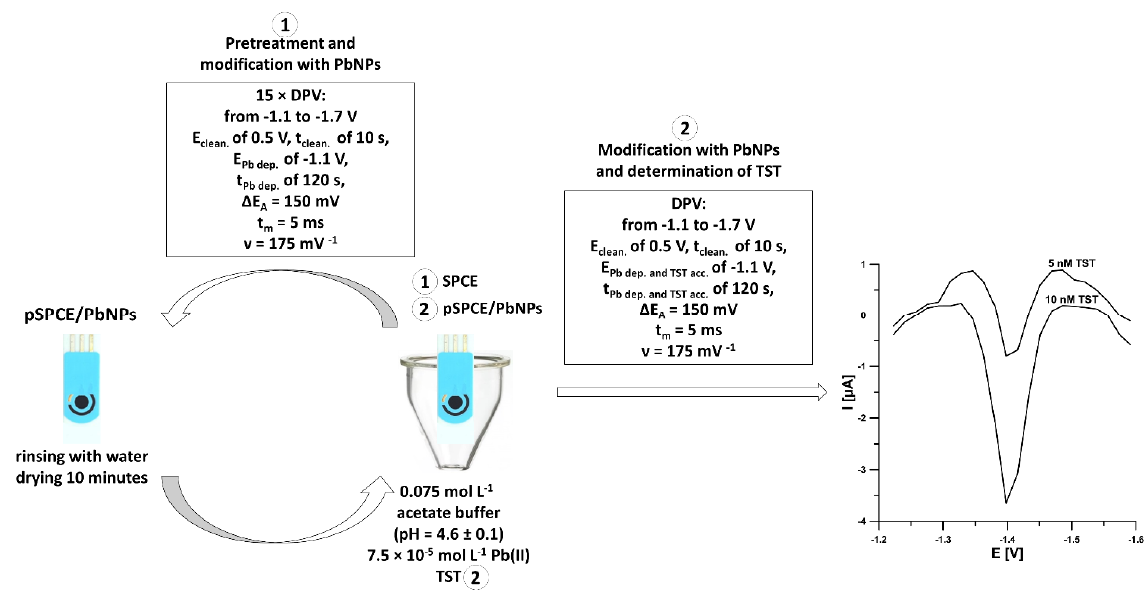
Figure 1. Scheme of sensor fabrication and voltammetric measurements of TST at the pSPCE/PbNPs.